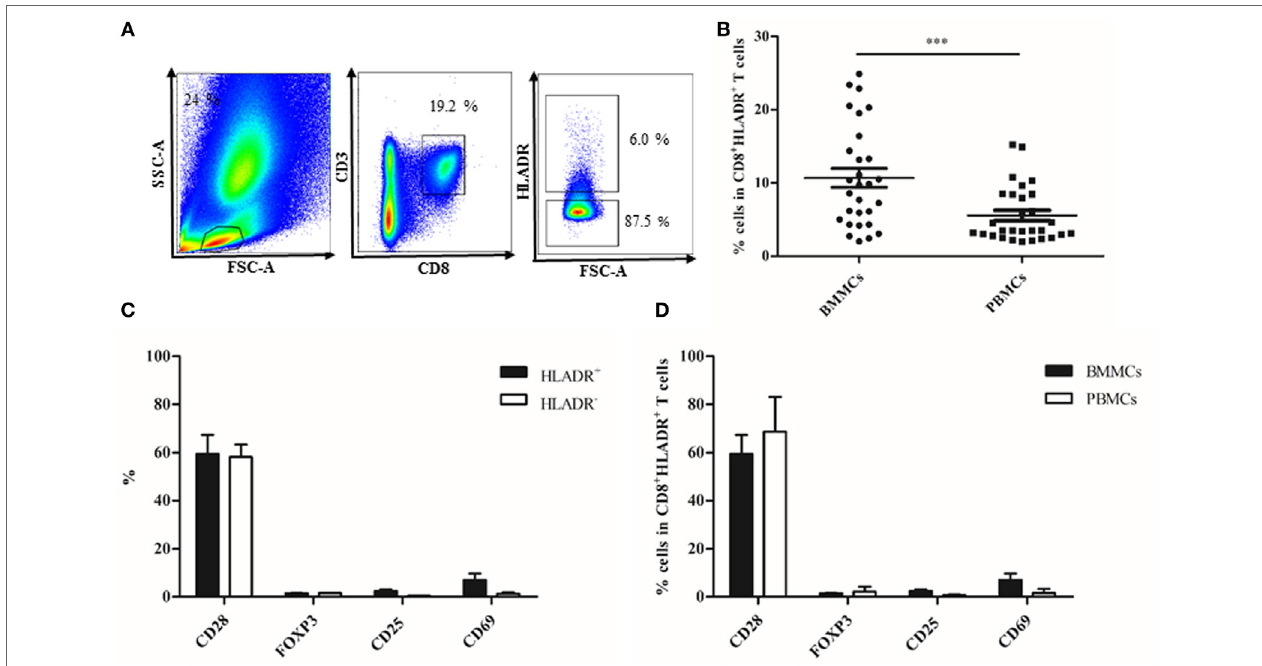
FigUre 4 | Phenotypical characterization of CD8 + human leukocyte antigen–antigen D related (HLADR) + and CD8 + HLADR − T cells in bone marrow mononuclear cells (BMMCs) and peripheral blood mononuclear cells (PBMCs) paired samples. (a) Representative FACS plots of the gating strategy in the bone marow. (b) Percentages of HLADR + cells in CD8 + T cells in BMMCs vs PBMCs; n = 29; mean ± SEM, *** p < 0.0001. (c) Percentages of CD28, FOXP3, CD25, and CD69 in CD8 + HLADR + and CD8 + HLADR − cells in BMMCs; n = 5; mean ± SEM. (D) Percentages of CD28, FOXP3, CD25, and CD69 in CD8 + HLADR + cells in BMMCs and PBMCs; n = 5; mean ± SEM.